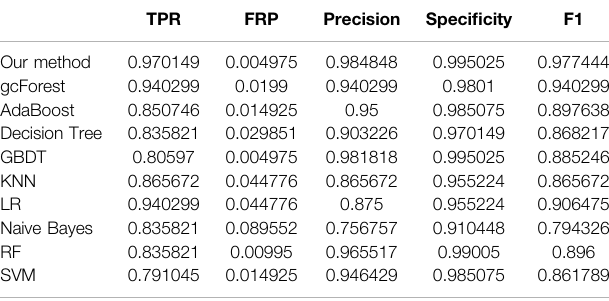
TABLE 1 | Classi fi cation performances of ten methods with 2-cross validation methods. TPR FRP Precision Speci fi city F1